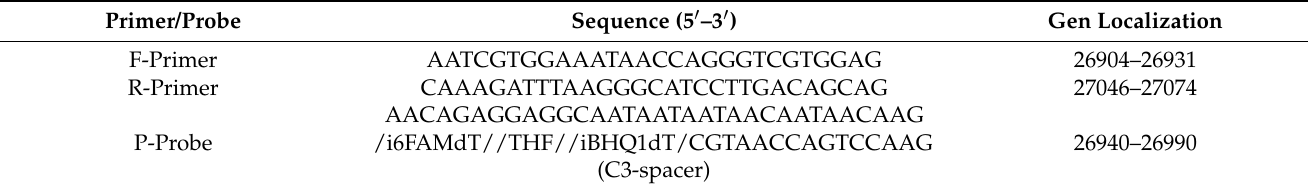
Figure 1. Schematic representation of the RAA-based amplification process: ( A ) reaction mechanism based on RAA recombination; ( B ) principle of real-time fluorescent RT-RAA. Table 1. Sequences of primers and probes for real-time RT-RAA